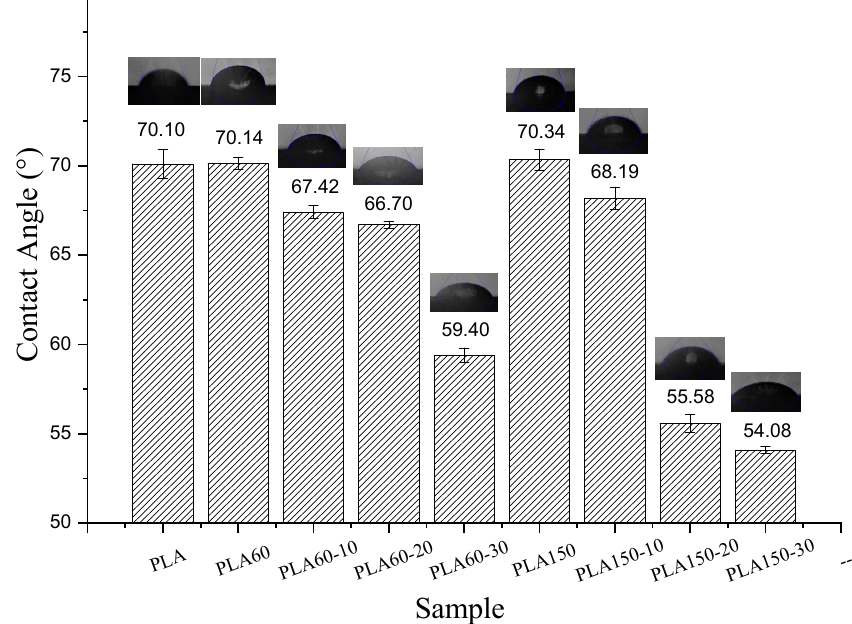
Figure 16. Average contact angle values for PLA and PLA/ATBC with different proportions.